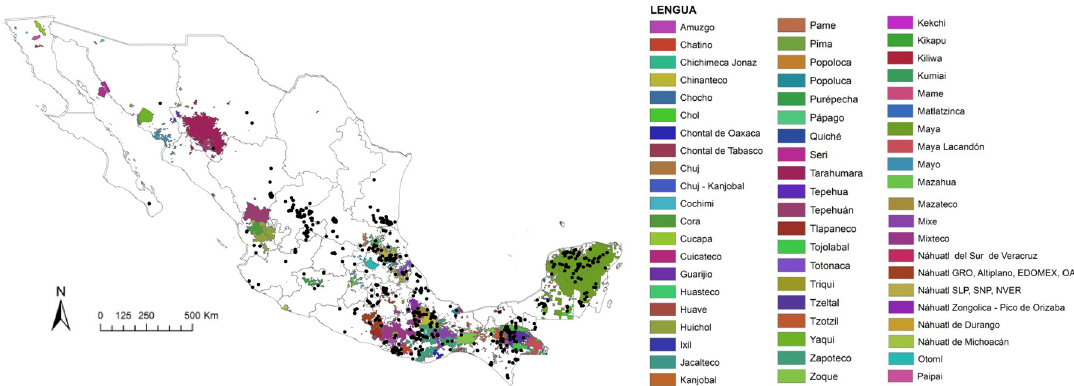
Figure 1. Distribution map of Capsicum annuum var. annuum in Mexico in relation to the indigenous cultures. The colored backgrounds indicate the territories of the 67 indigenous languages spoken in Mexico. (Map elaborated by A. Aguilar- Mel é ndez and Andr é s Lira-Noriega from personal and CONABIO databases, and for the Amerindian territories, from maps provided by INALI and the anthropologist Eckart